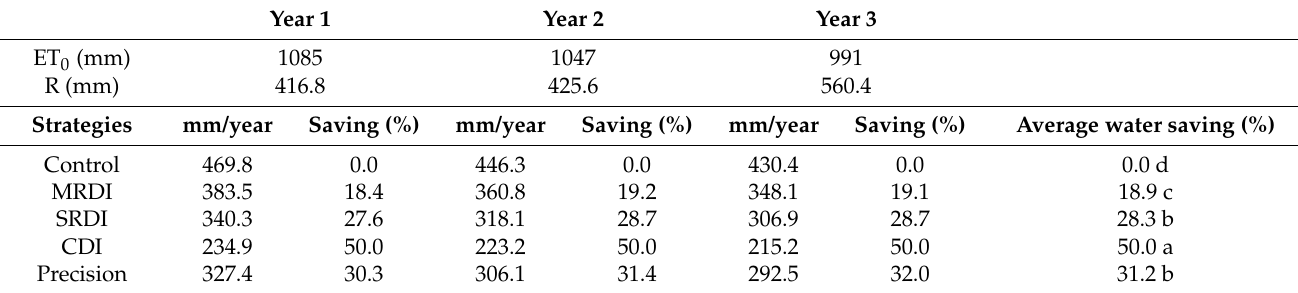
Table 3. Annual values of potential evapotranspiration (ET 0 ), rainfall (R), irrigation water applied (mm), and water saving (%) for the irrigation strategies during the three years of the experiments. (MRDI: moderate regulated deficit irrigation; SRDI: severe regulated deficit irrigation; CDI: continu- ous deficit irrigation). Different letters showed significant differences ( p ≤ 0.05) among treatments according to Duncan’s test.